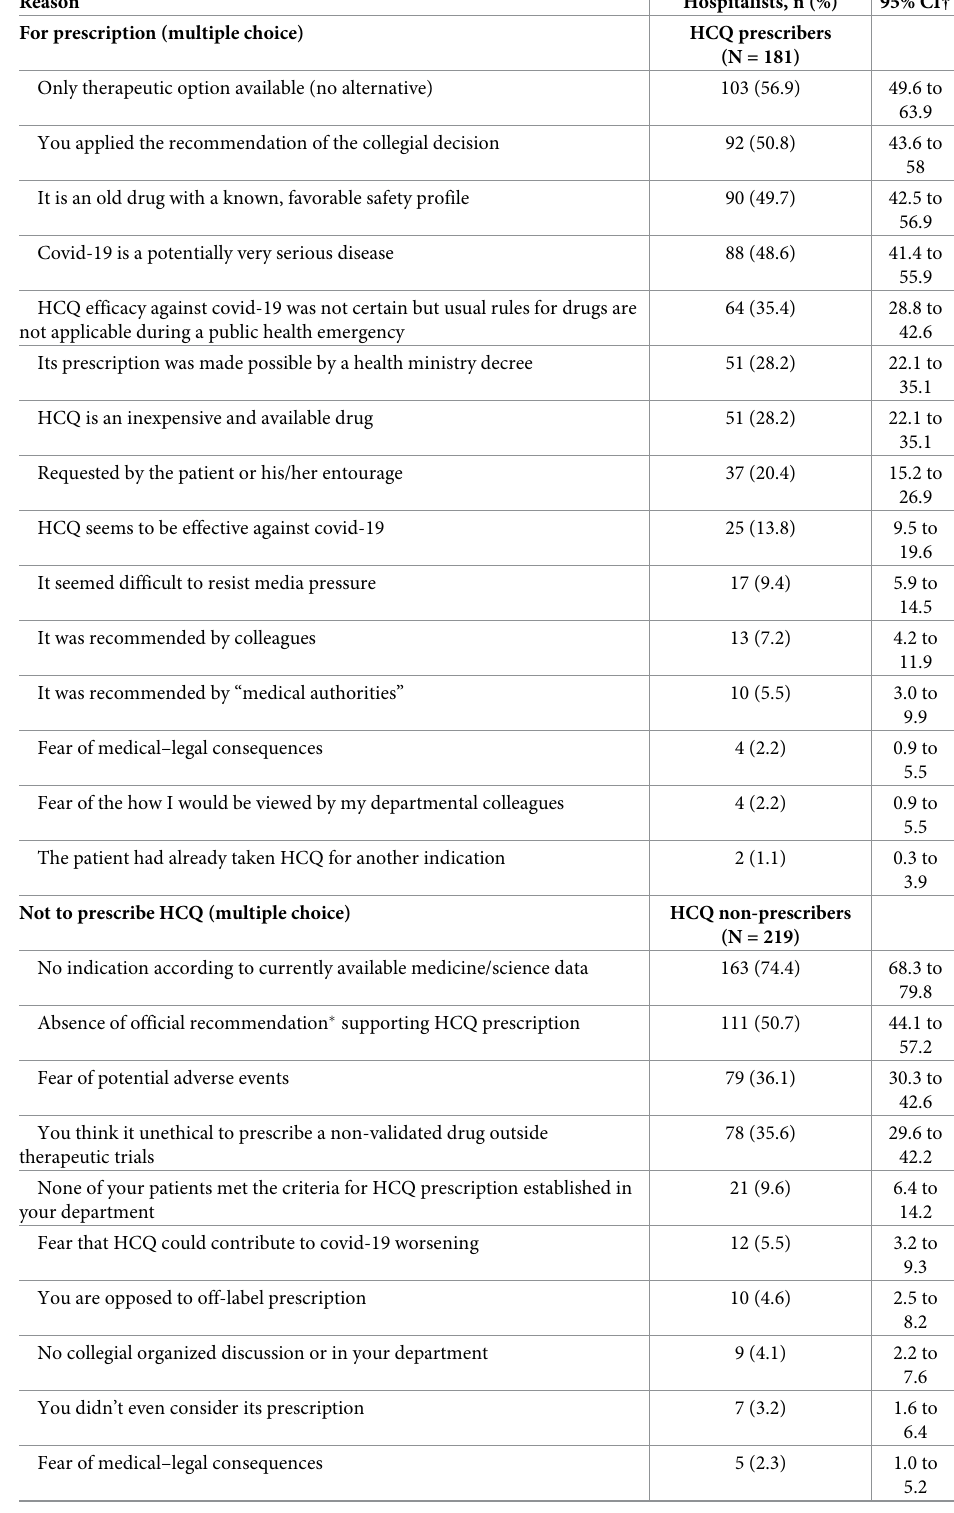
Table 2. Physicians reasons for prescribing HCQ or